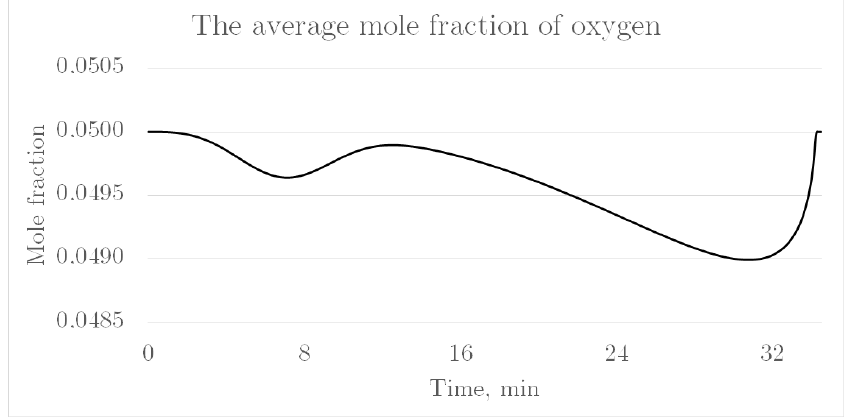
Figure 8. Dynamics of the average molar fraction of oxygen in the reaction mixture in the pores of the catalyst grain.